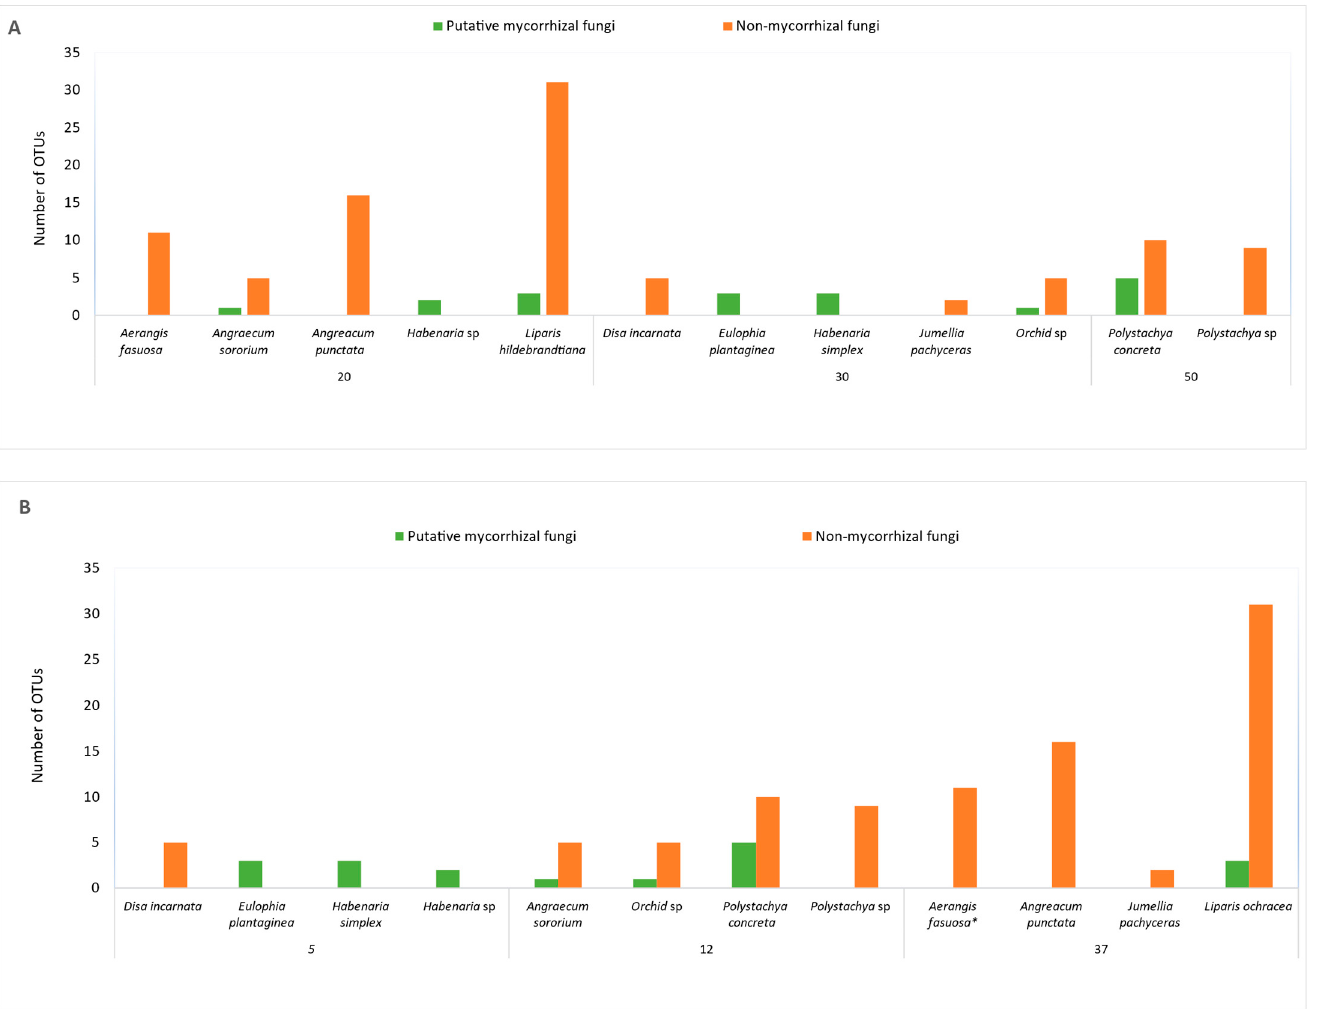
Figure 3. Fungal diversity, both putative mycorrhizal and non-mycorrhizal, in 12 orchids collected during the rainy season relative to nitrogen ( A ) and phosphorus ( B ) content in the soil.